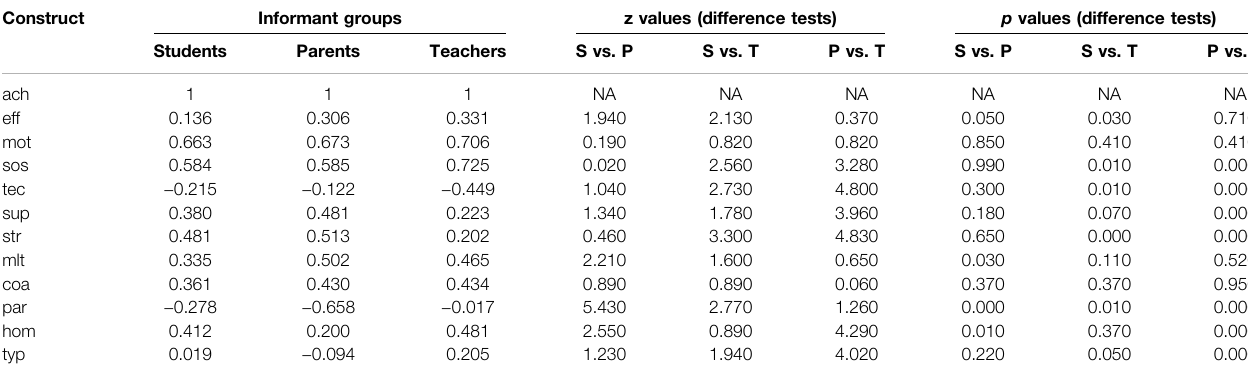
TABLE 4 | Latent correlations of the study variables with achievement outcome. Construct